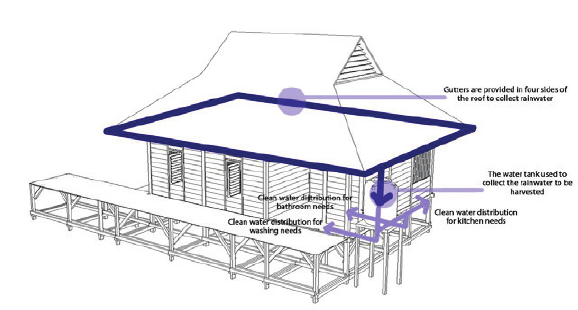
Figure 10. Air circulation concept